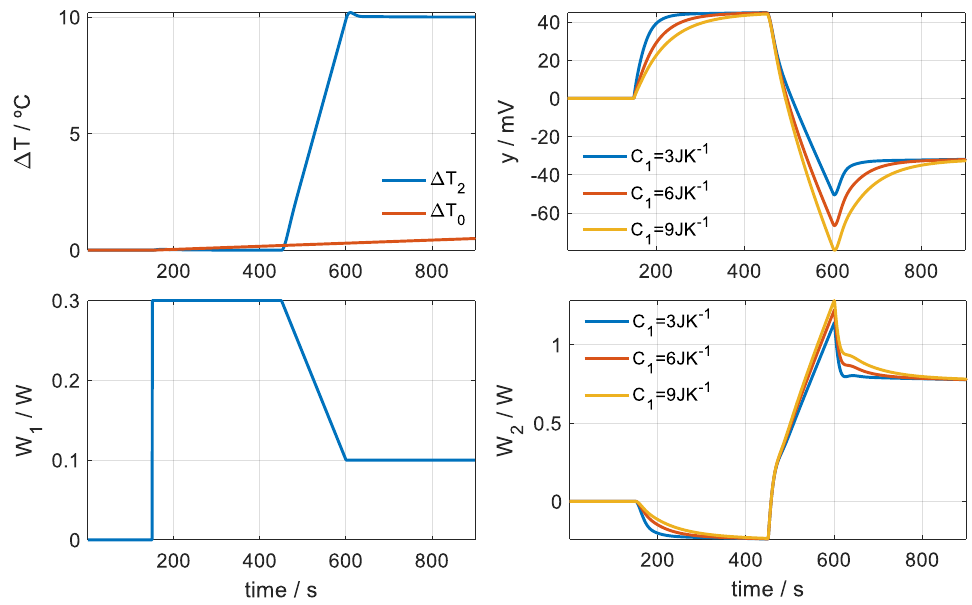
Figure 7. Simulations for the case of calibrations on a base that has different heat capacities. Curve baselines have been corrected.